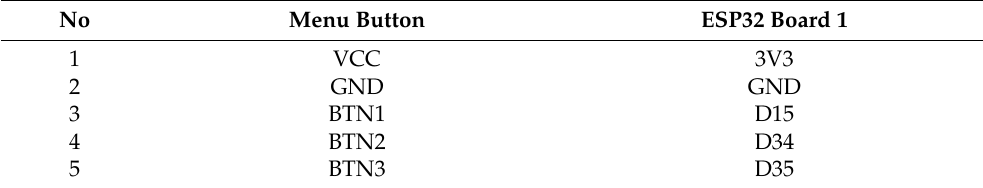
Table 2. Connection between button and ESP32 Board 1.